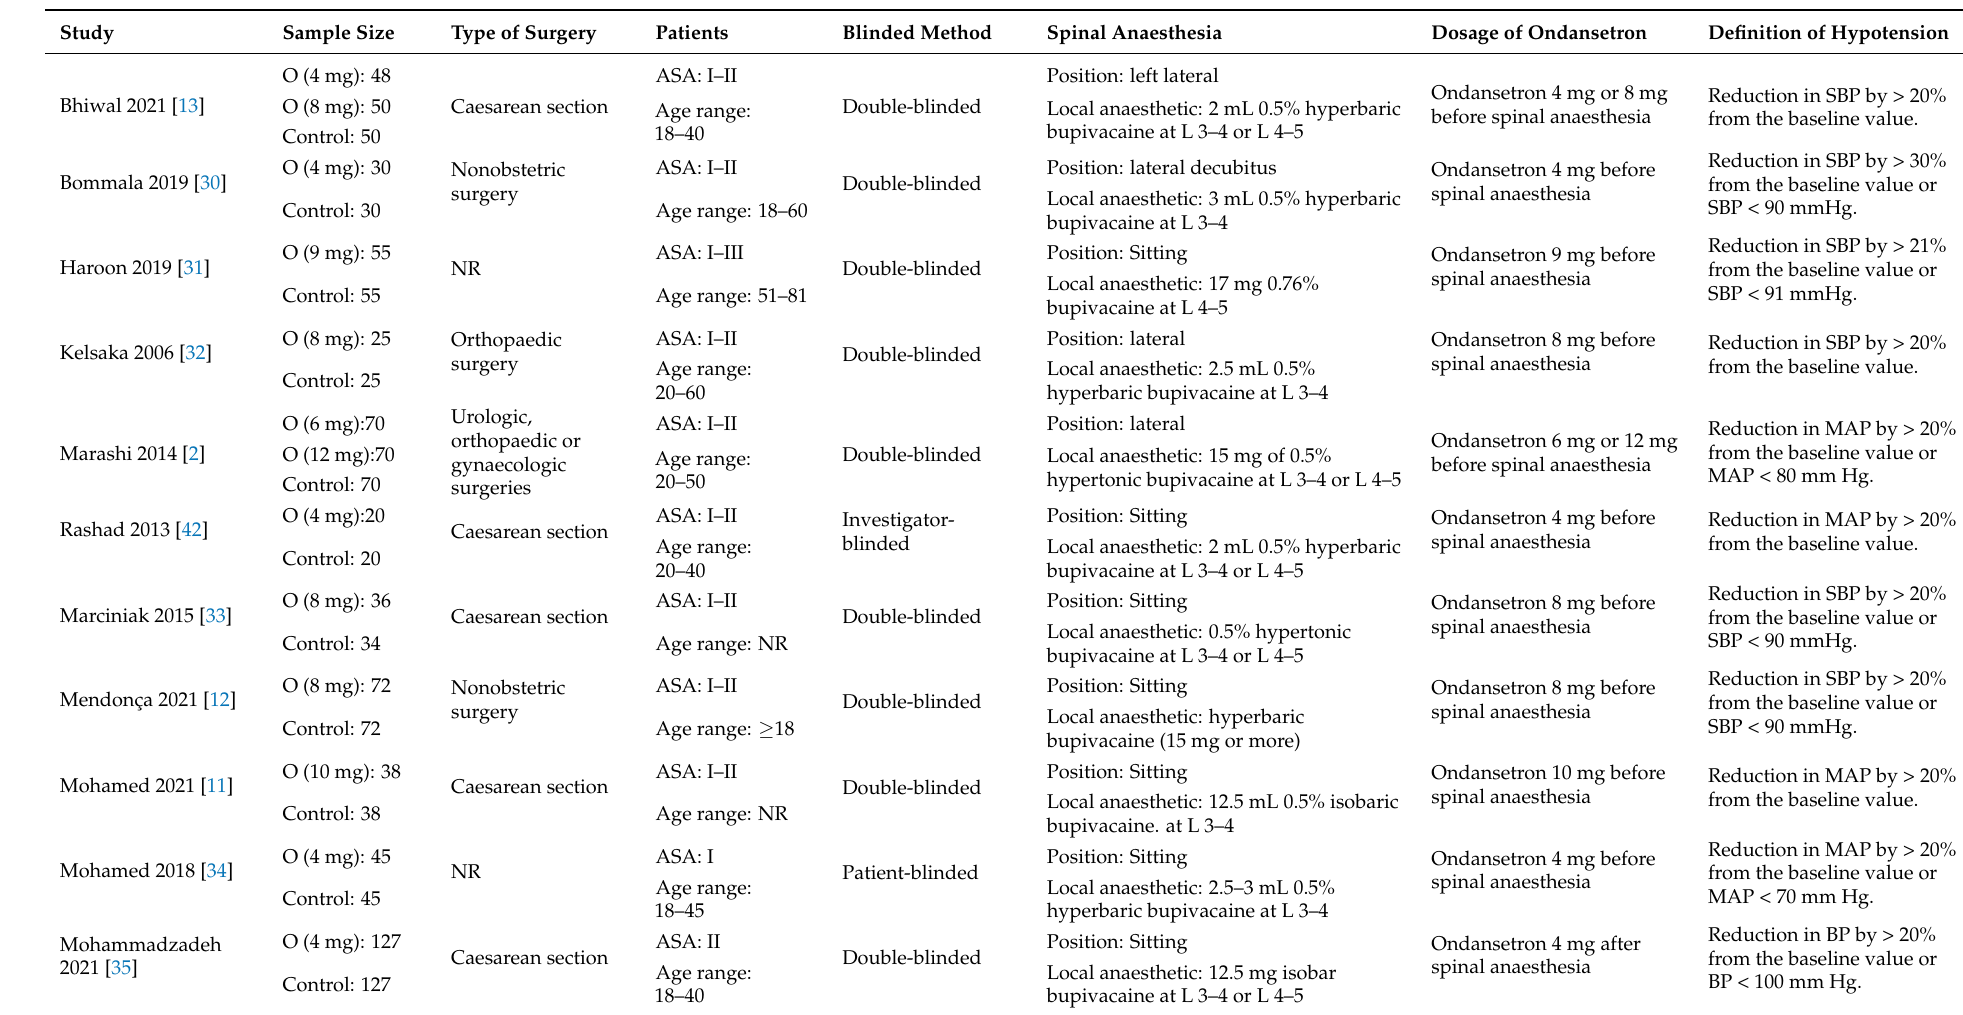
Table 1. The details of the included